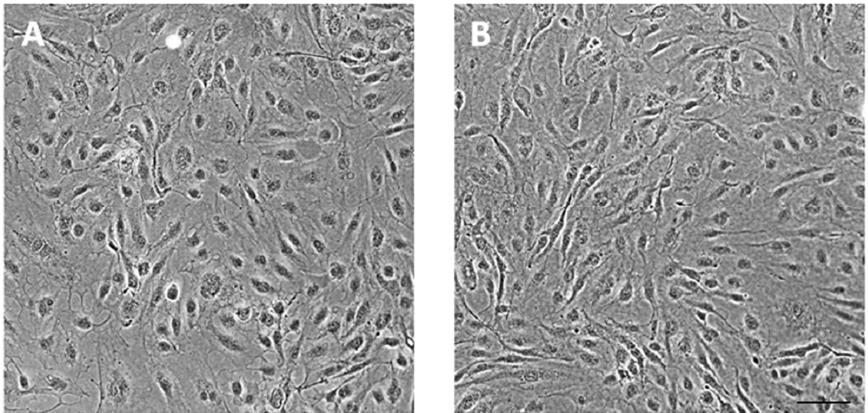
Figure 1. Control cells cultured under standard conditions did not show GFP expression. Control groups were cells cultured in pure medium ( A ) and in medium supplemented with 1 μ g of plasmid ( B ). Bar = 50 μ m.